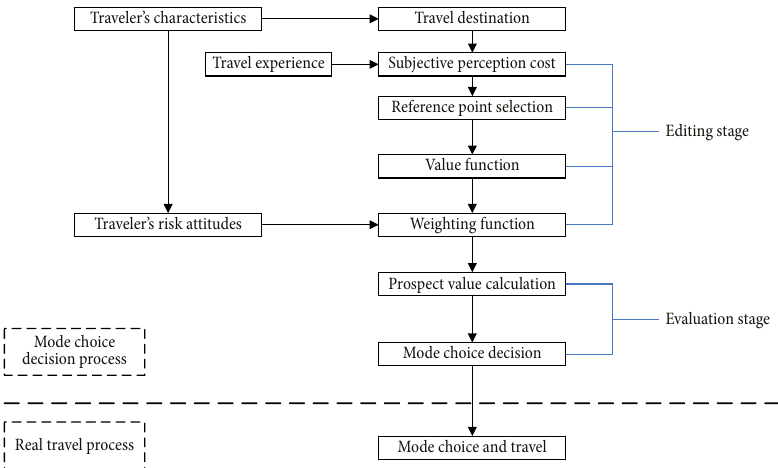
Fig. 1. Modelling and analysing framework of travel’s mode choice behaviour based on cumulative prospect